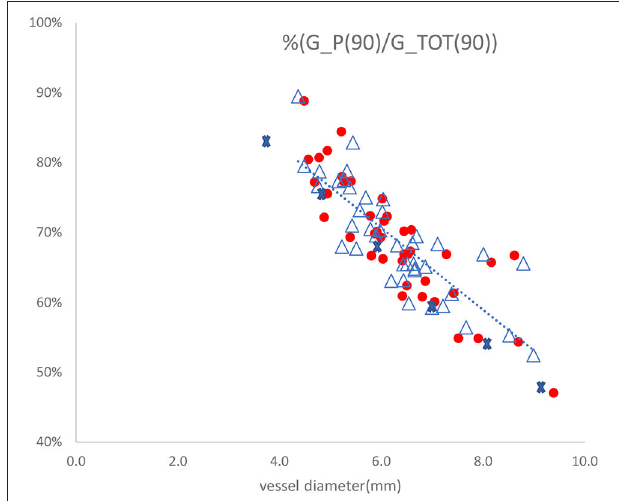
FIGURE 6 | Ratio of parallel conductance to total conductance as function of vessel diameter for 25 patients with the two-injections method using 5-5-5 guidewire. The dotted line represents linear regression fit to the measured values with R-squared value of 0.682. The points shown by cross marks are the values predicted by the model. The other marks are the parallel conductance ratios measured twice for each patient with 0.9% saline